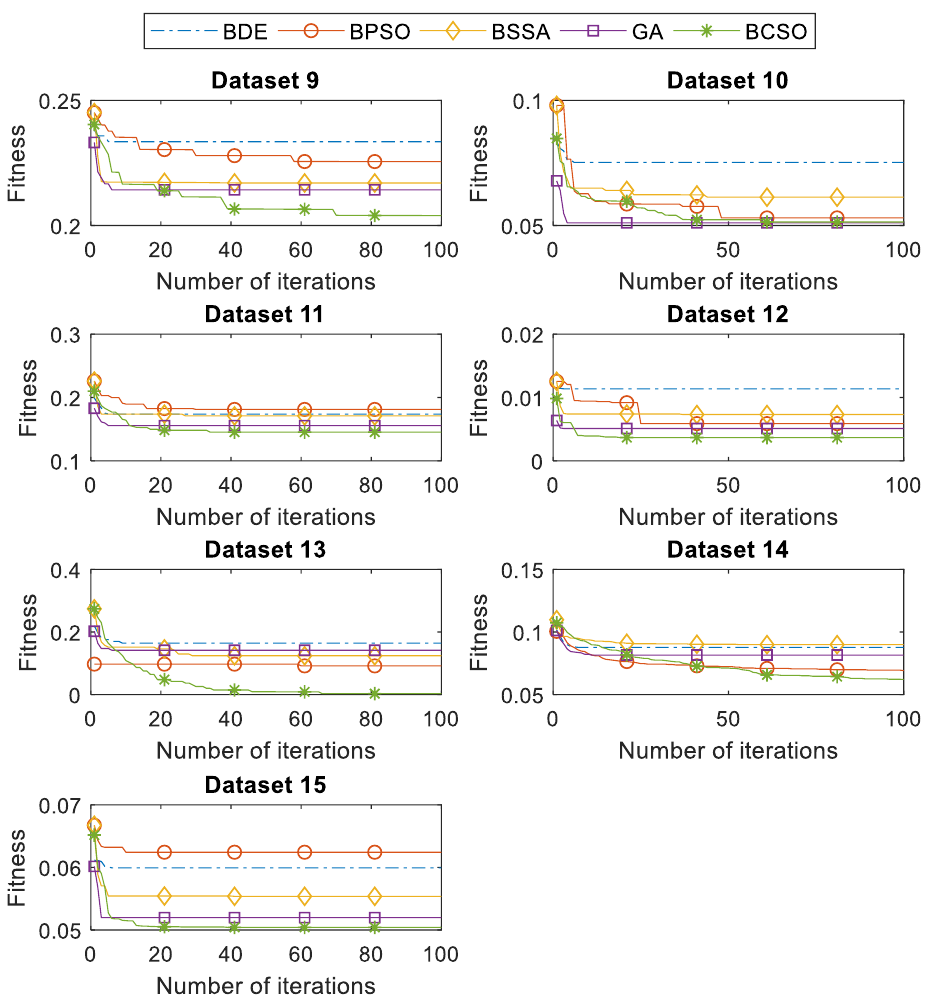
Figure 6. Convergence curves of BDE, BPSO, BSSA, GA, and BCSO on datasets 9 – 15.